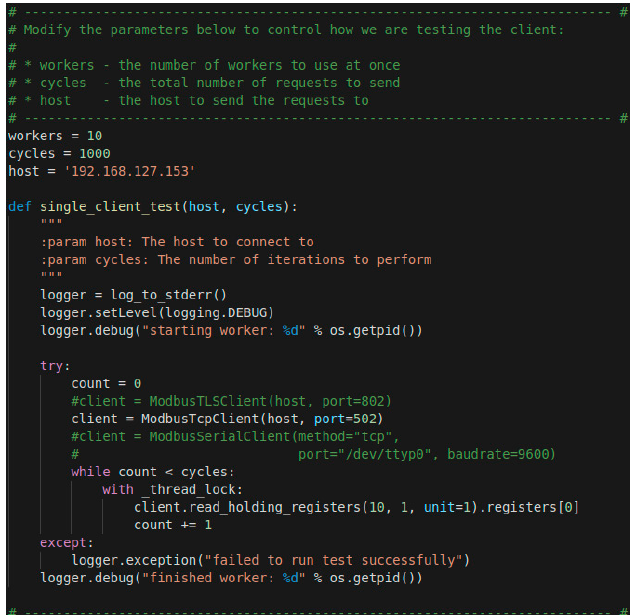
Figure 11. Read Holding function used to evaluate the performance.